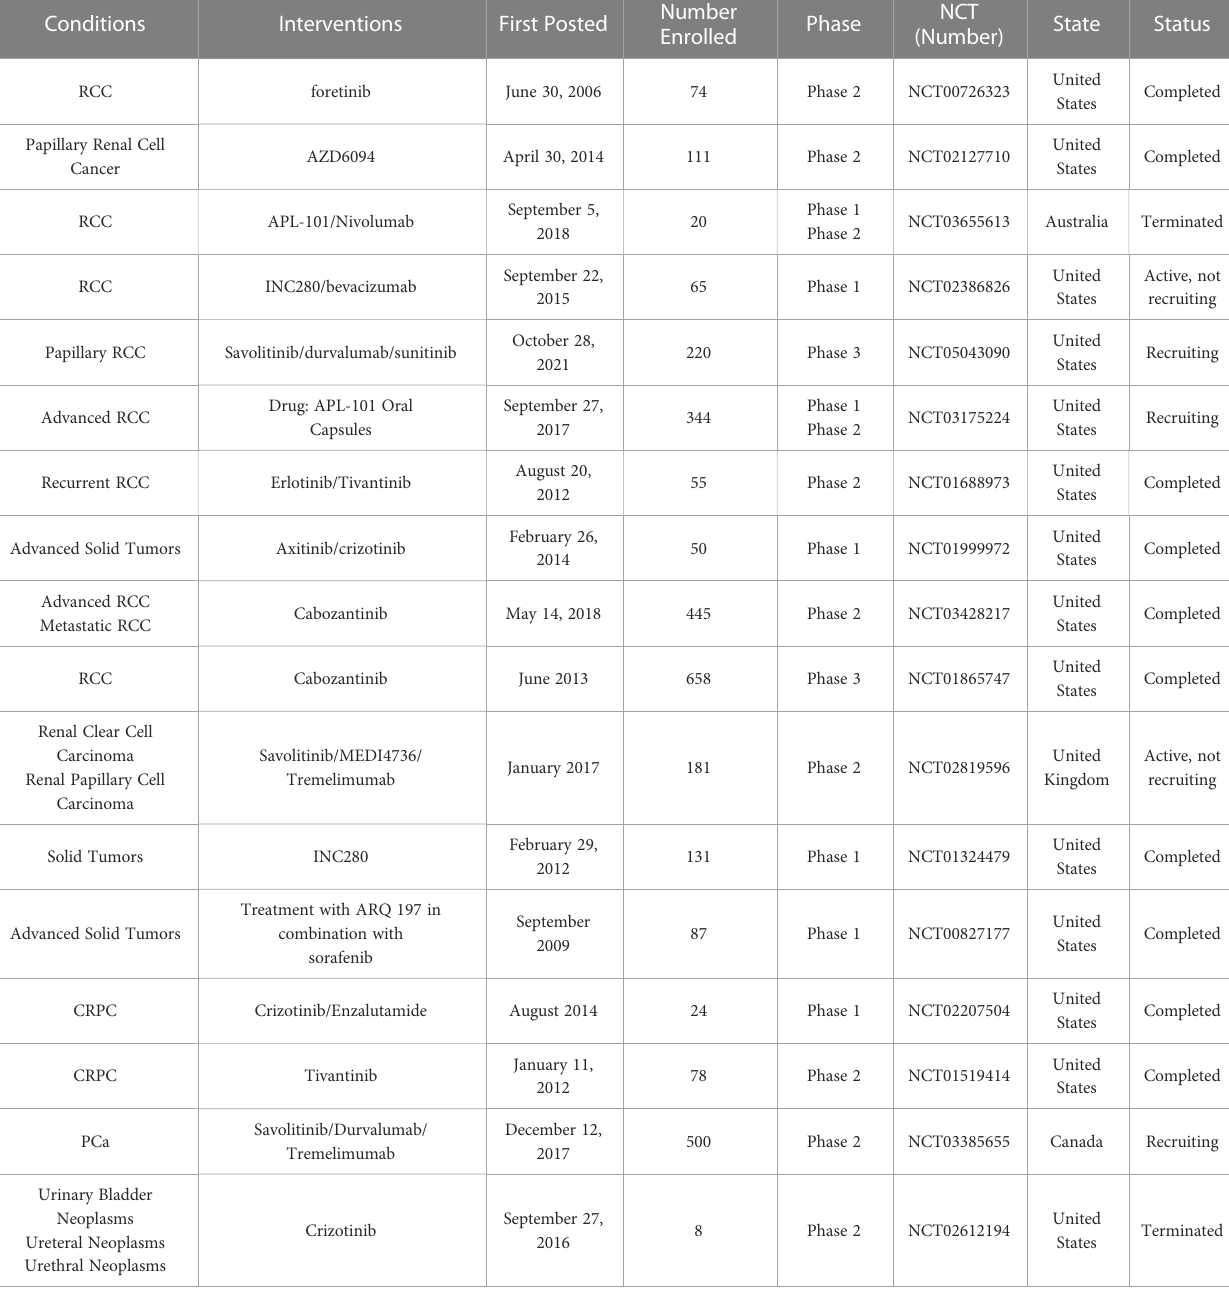
TABLE 3 Clinical studies of c-Met targeting therapy in urologic neoplasms.